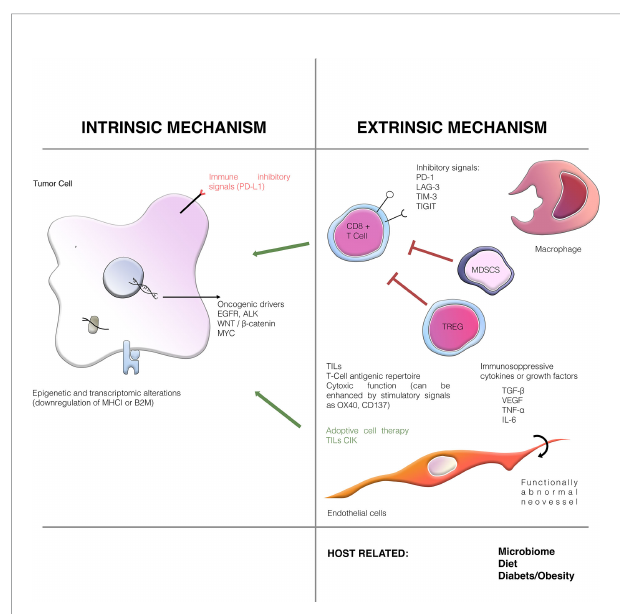
FIGURE 1 | Mechanisms of resistance to immunotherapy and main molecular pathways